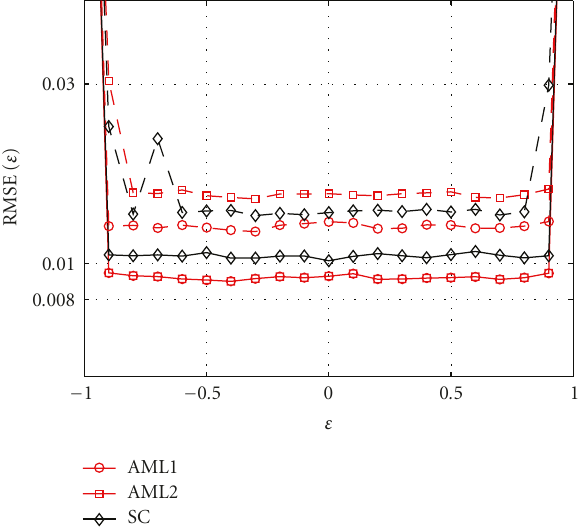
Figure 8: Performance of the considered CFO estimators as a function of the number of subcarriers in ITU Vehicular A multipath channel.